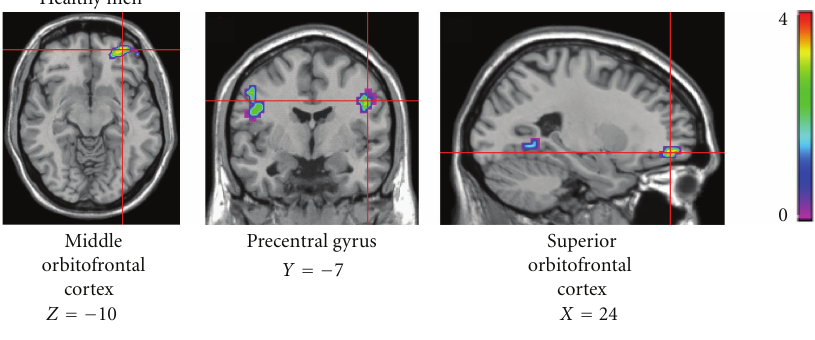
Figure 2: Correlation between progesterone levels and brain activations during processing of negative